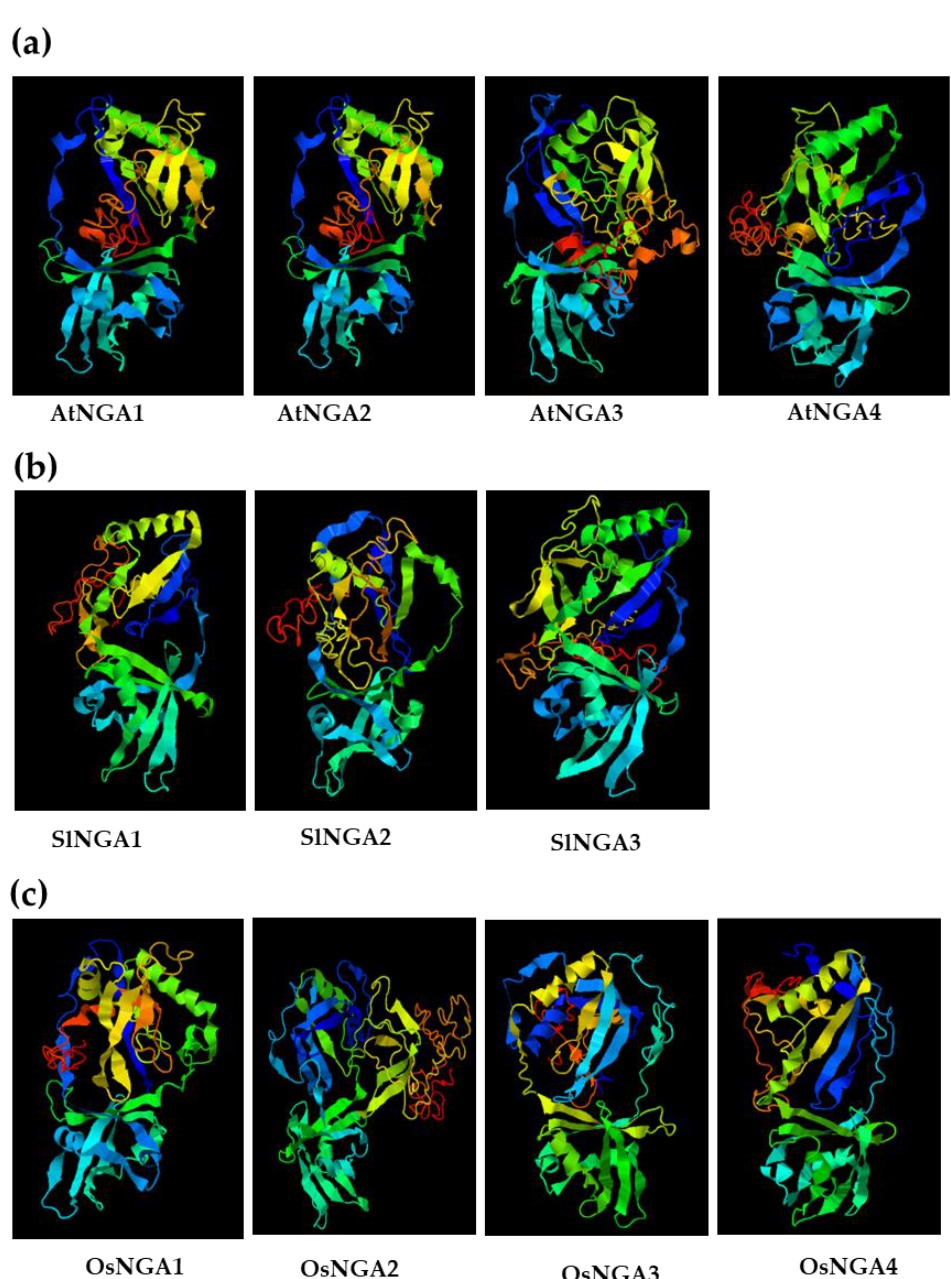
Figure 4. The 3D-structure of the NGATHA proteins in ( a ) A. thaliana , ( b ) S. lycopersicum , and ( c ) O. sativa L. Japonica. The three-dimensional structures were acquired using I-TASSER (https://zhang- group.org/I-TASSER/; accessed on 18 January 2022) [35]